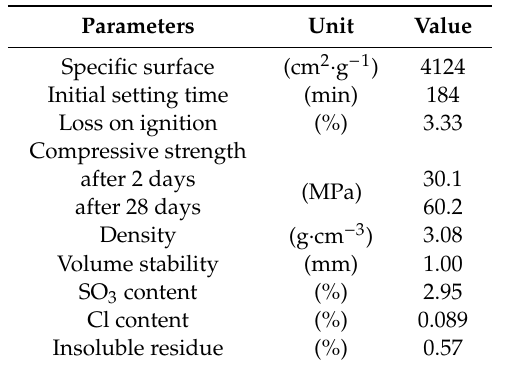
Table 1. The technical parameters of CEM I 42.5R Portland cement.